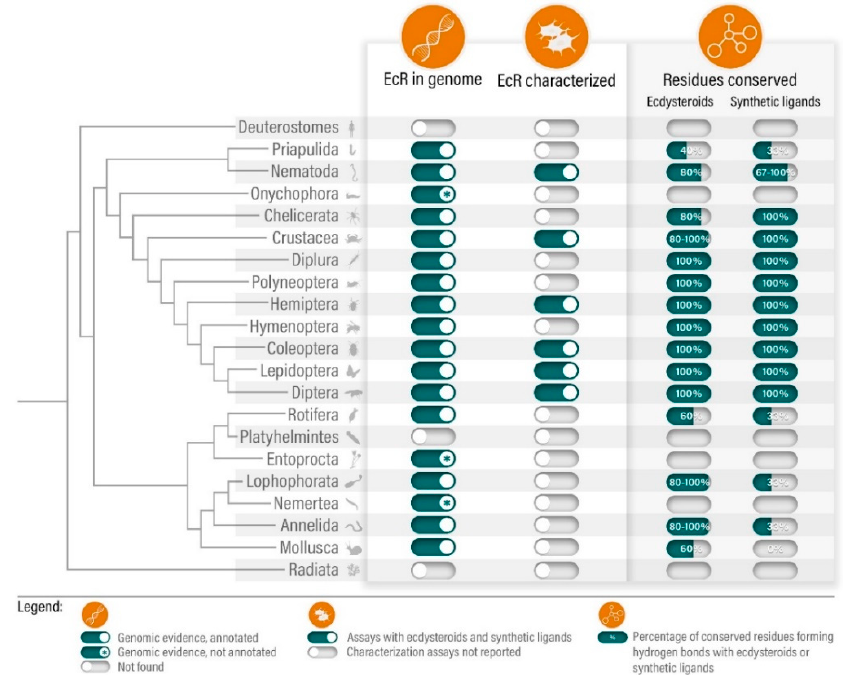
Figure 1. Summary of the state-of-the-art regarding the phylogenetic distribution and functional mapping of EcRs across metazoans.